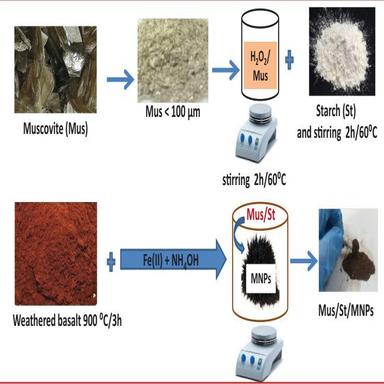
Schematic representation of the main steps used in the synthesis of Mus/St/MNPs.